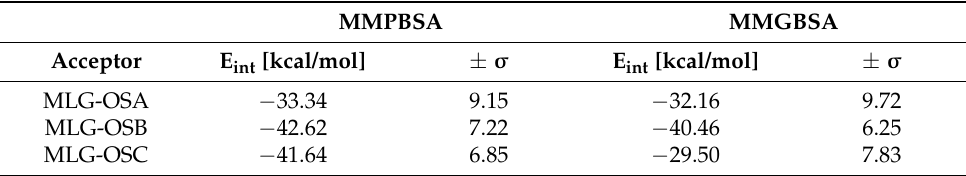
Figure 7. Positions of the XG-OS7 donor and docked MLG-OS acceptor substrates that interact with the TmXET6.3 residues (interactions shown at the acceptor sites). The residues that interact with acceptors over 50% of MD simulation times at distances of up to 4.0 Å (right, black letters) are shown at the beginning (0 ns) and after 1000 ns of MD simulation times. Catalytic residues are shown in red letters. Table 7. Binding free energy values of TmXET6.3 in complex with MLG-OS acceptors based on MM(PB/GB)SA calculations. Values were obtained from 800–1000 ns time intervals of MD